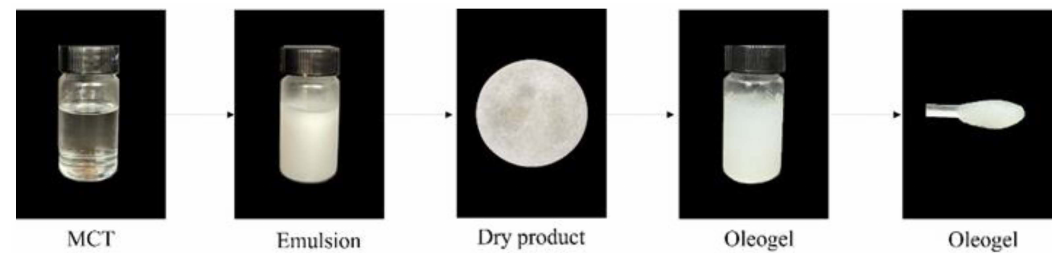
Figure 4. The process of preparation for oleogels.